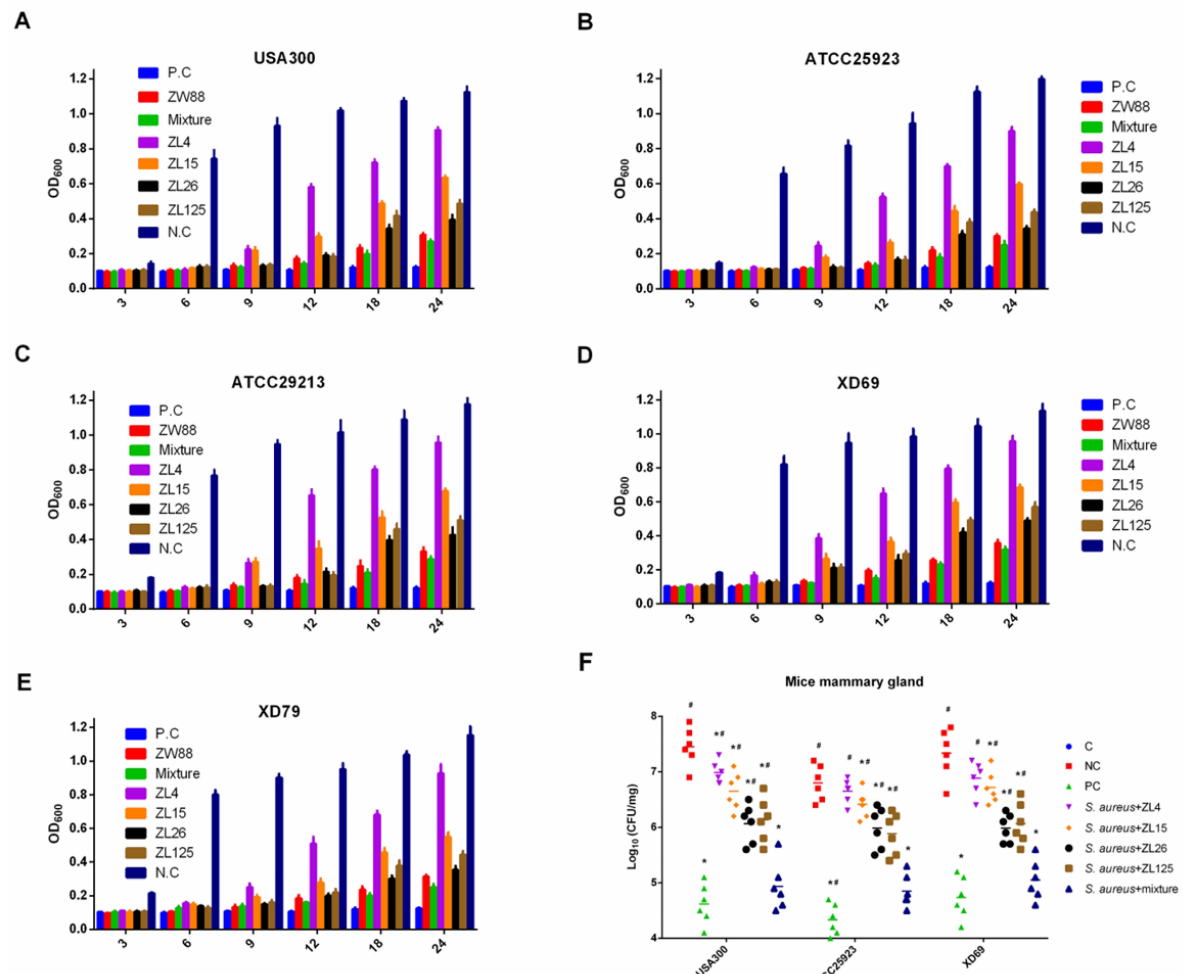
Figure 4. Function of scFvs to growth inhibition of S. aureus strains USA300 ( A ), ATCC25923 ( B ), ATCC29213 ( C ), XD69 ( D ), and XD79 ( E ). ( F ) Bacteria proliferation was inhibited by four scFvs in vivo. S. aureus strains were cultured in TSB containing physiological saline, scFvs or penicillin (final concentration of both scFv/mixture and penicillin were 40 µ g/mL). Data represent mean results ± SD ( n = 3 or 6). # p < 0.05 vs. scFvs mixture group. * p < 0.05 vs. negative control group.